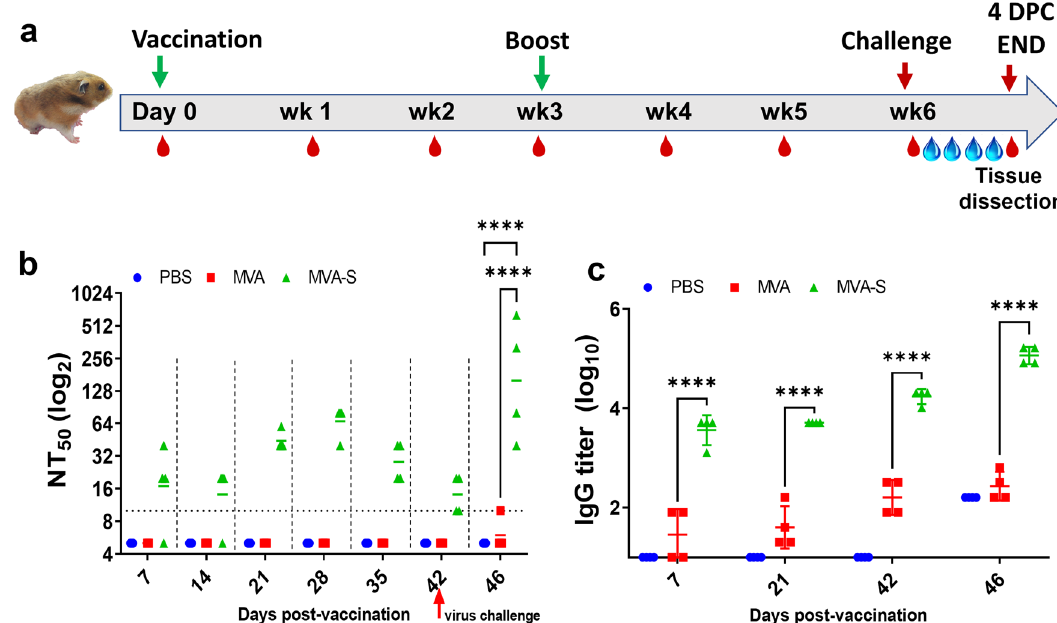
Fig. 3 Experimental design and antibody responses to vaccination in Syrian hamsters. a Adult Syrian hamsters ( n = 4) were vaccinated with MVA-S, MVA (empty vector), or PBS on days 0 and 21 with blood collection weekly until challenge in week 6. b Sera from collected blood samples were tested for neutralizing antibody at each week for 6 weeks and at 4 days post challenge. c Sera were tested for S-speci fi c IgG at weeks 1, 3, and 6. **** P <